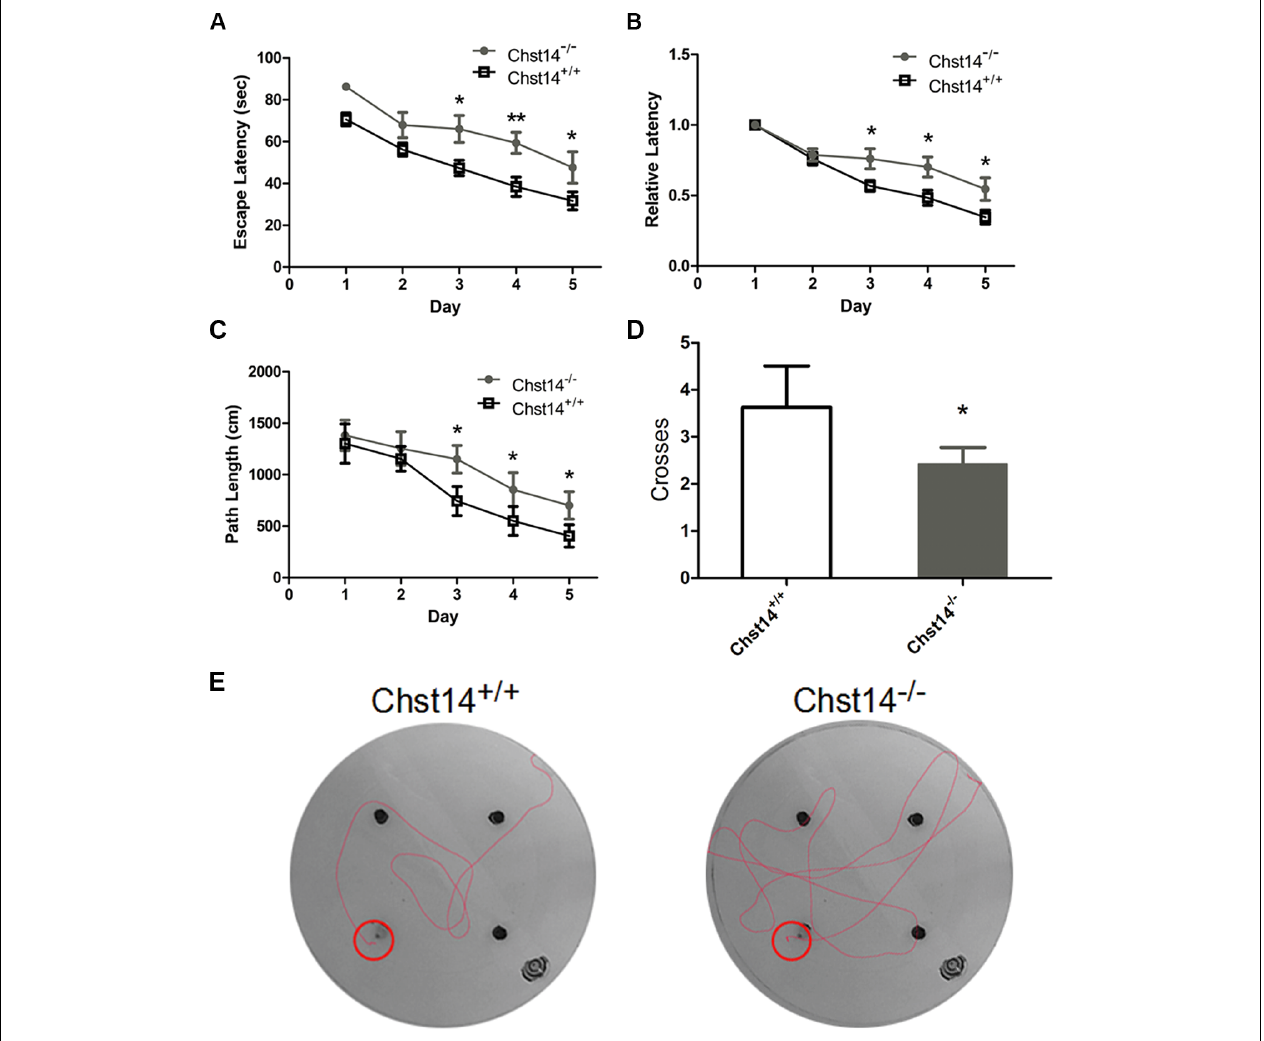
FIGURE 1 | Chst14/D4st1 deficiency leads to impaired spatial learning and memory. Morris Water Maze (MWM) tests were performed on wild type (WT; n = 16) or Chst14 − / − mice ( n = 12) and animal behaviors were recorded and analyzed. (A) The escape latencies in each group of the mice were analyzed. (B) The escape latencies of each group of mice on the first day were normalized to 1.0. The relative escape latencies in the subsequent days to that of the first day were calculated. (C) The average distances that the mice spent to find the platform. (D) The times that each group of mice swam across the target sites after retrieval of the platform. (E) Representative images of the path that the mice swam along to find the platform. Data are presented as mean ± standard error of the mean (SEM) in each group. ∗ p < 0.05, ∗∗ p <